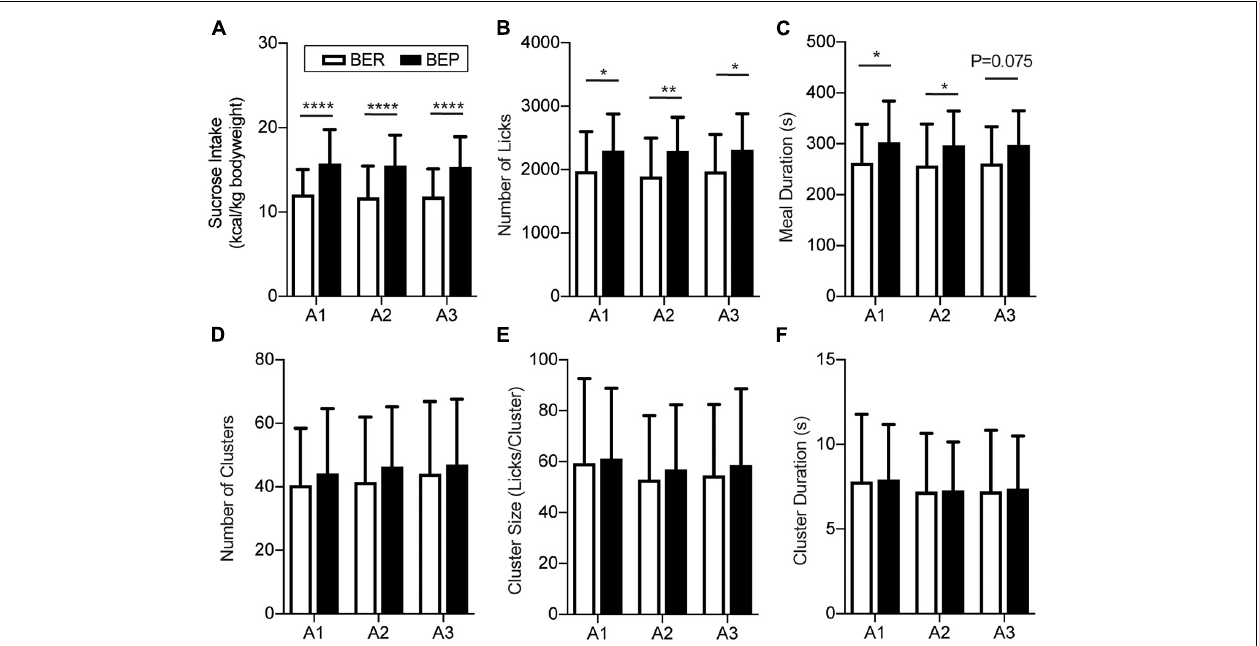
FIGURE 2 | Feeding behavior during appetitive sessions. Binge-like eating prone (BEP) rats showed constant higher sucrose intake during the Appetitive sessions compared to binge-like eating resistant (BER) rats. (A) Sucrose intake normalized to body weight. Licking microstructures during the Appetitive sessions: total number of licks (B) , meal duration (C) , number of clusters (D) , cluster size (E) , and cluster duration (F) . *Significantly different ( p < 0.05) between the BEP group and BER group. ** p < 0.01, **** p <